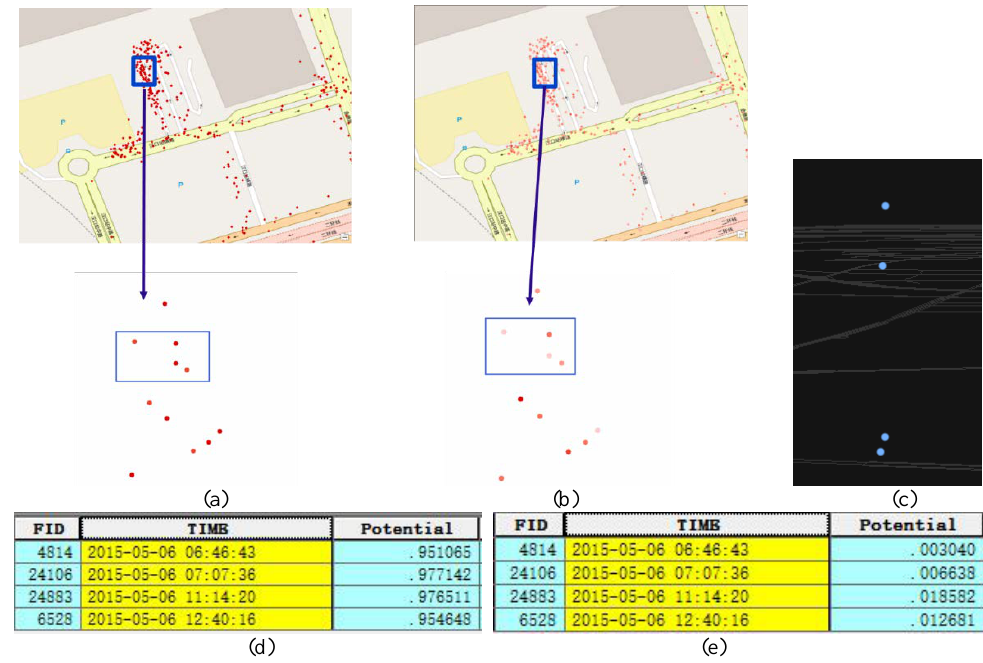
Figure 5. The comparision result between traditional data field method and sptio-temporal data field method. (a) The cluster result of traditional data field method, (b) The cluster result of spatiotemporal data field method, (c)3D visualization of four example points, (d)time information and potential value in traditional data field, (e)potential value in spatiotemporal data field.